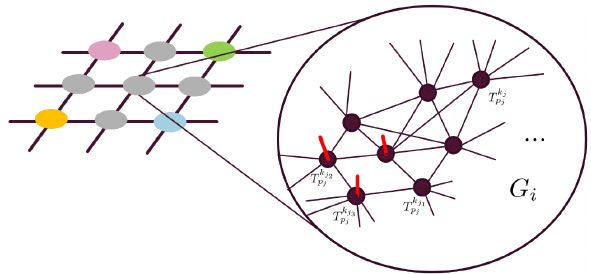
FIG. 14. A network architecture where the subgraph G i may have all-to-all connectivity below a certain scale even though the connection is sparse and local on a sufficiently coarse-grained level. Colored edges represent logical